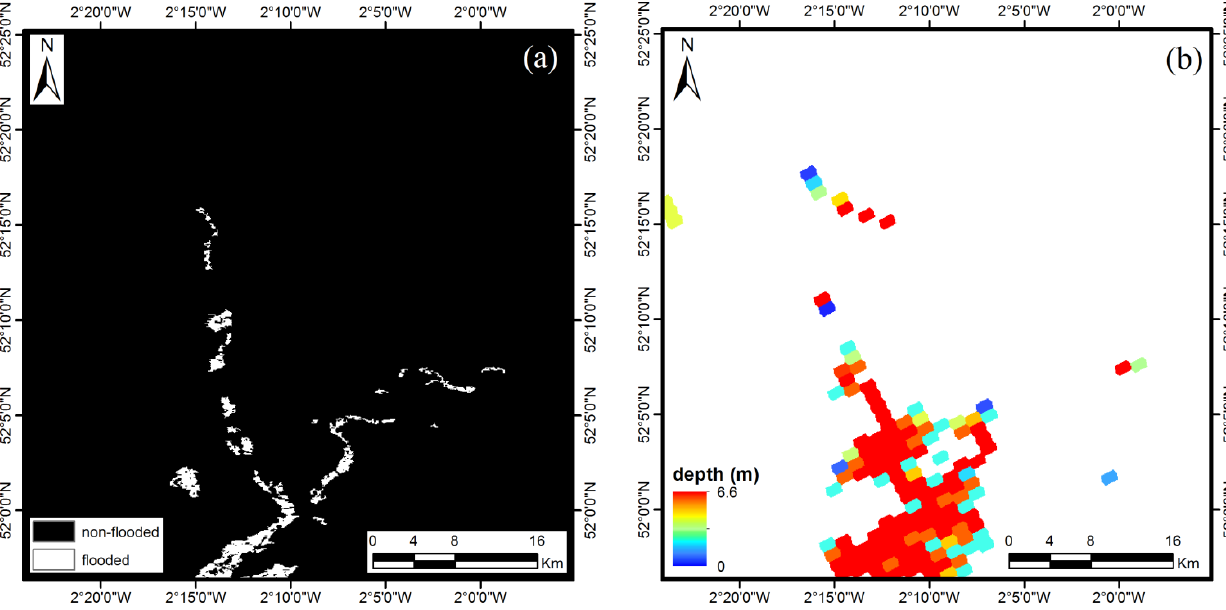
Figure 4. Example of ( a ) flood binary map and ( b ) corresponding daily PDWC2012 depth map, for the selected